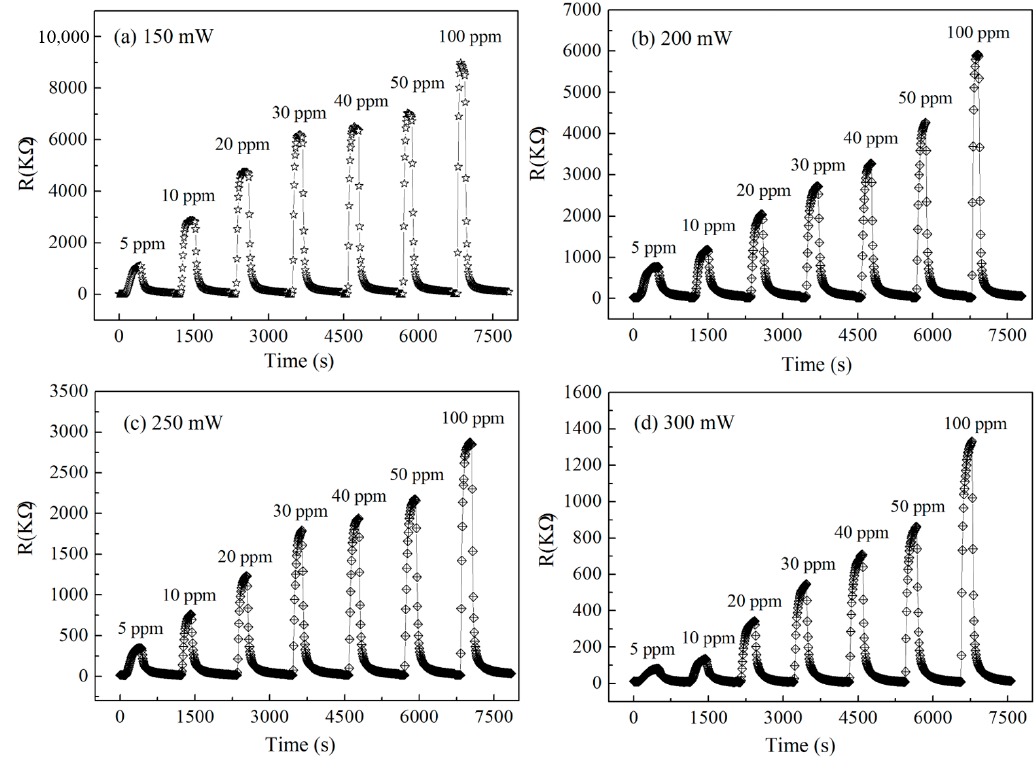
Figure 10. Gas sensing response and recovery property curves of the micro hotplate sensor detecting high concentration NO 2 at different power consumptions of ( a ) 150; ( b ) 200; ( c ) 250; and ( d ) 300 mW in the range of 5 to 100 ppm.